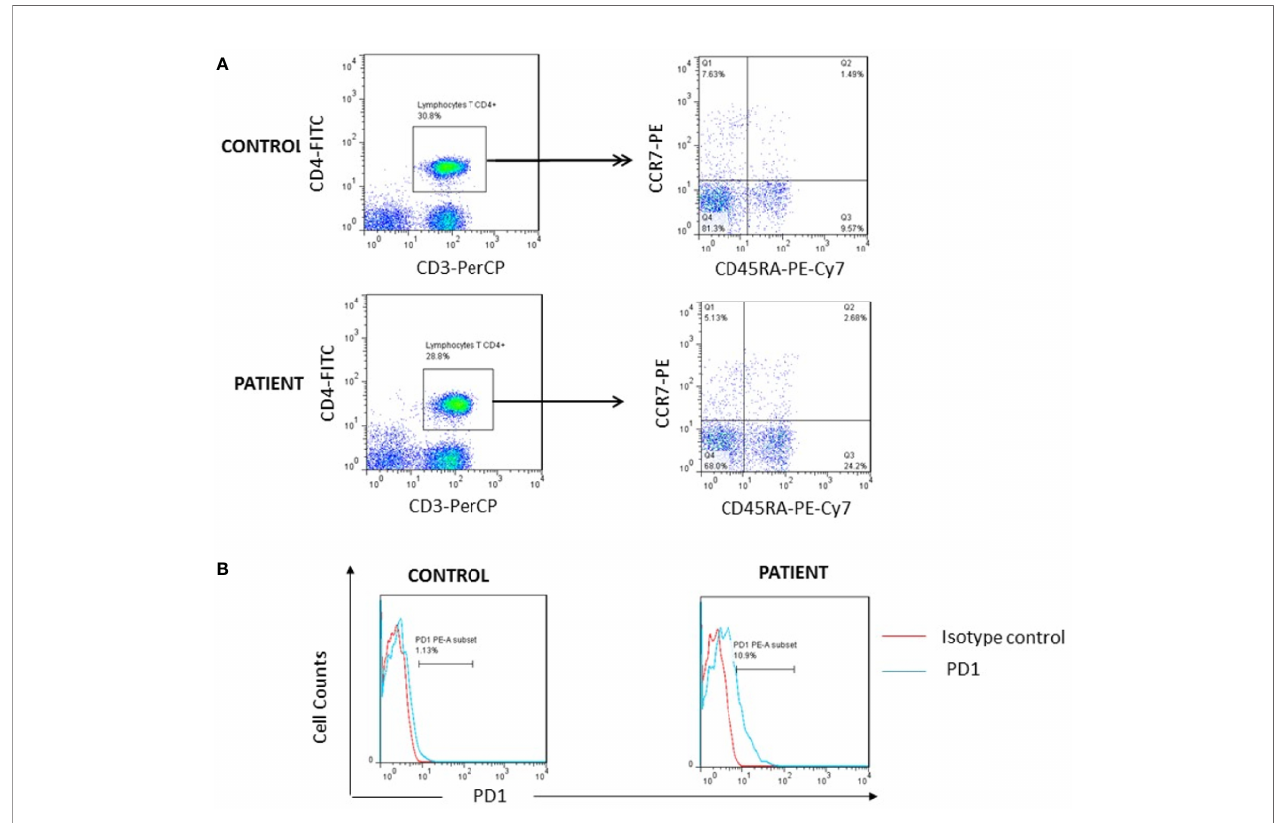
FIGURE 3 | Investigation of T cell exhaustion. (A) High percentage of TEMRA cells (Q3) was found in patient after whole blood staining with anti-CD3/PerCP, anti- CD4/FITC, anti-CD45RA/PE-Cy7 and anti-CCR7/PE as compared to one representative healthy control. (B) Increased surface expression of PD1 on the patient ’ s CD4+ lymphocytes as compared to one representative